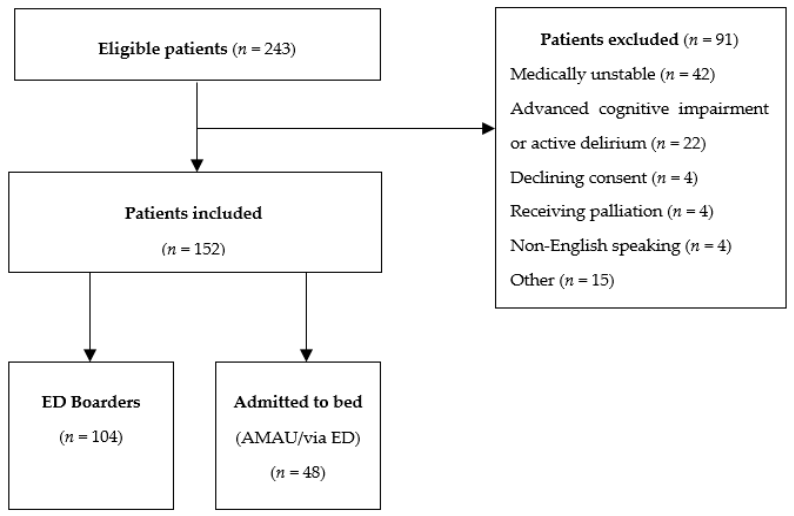
Figure 1. Flow diagram detailing patient selection including those boarding in the Emergency Department (ED) or admitted directly from ED or from the Acute Medical Assessment Unit (AMAU). Table1.